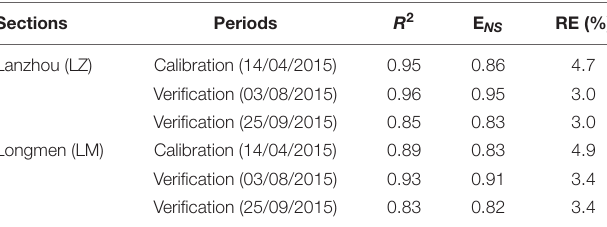
TABLE 3 | Calibration and verification results of the MIKE 21